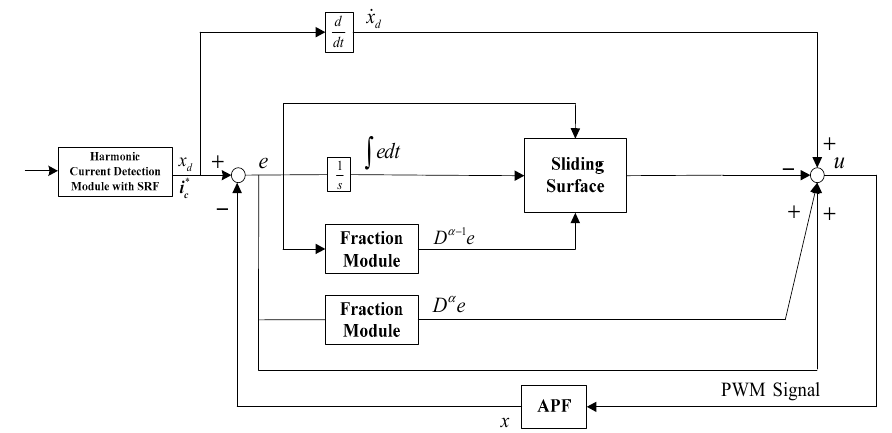
Figure 3. Block diagram of the FOSMC for an APF .